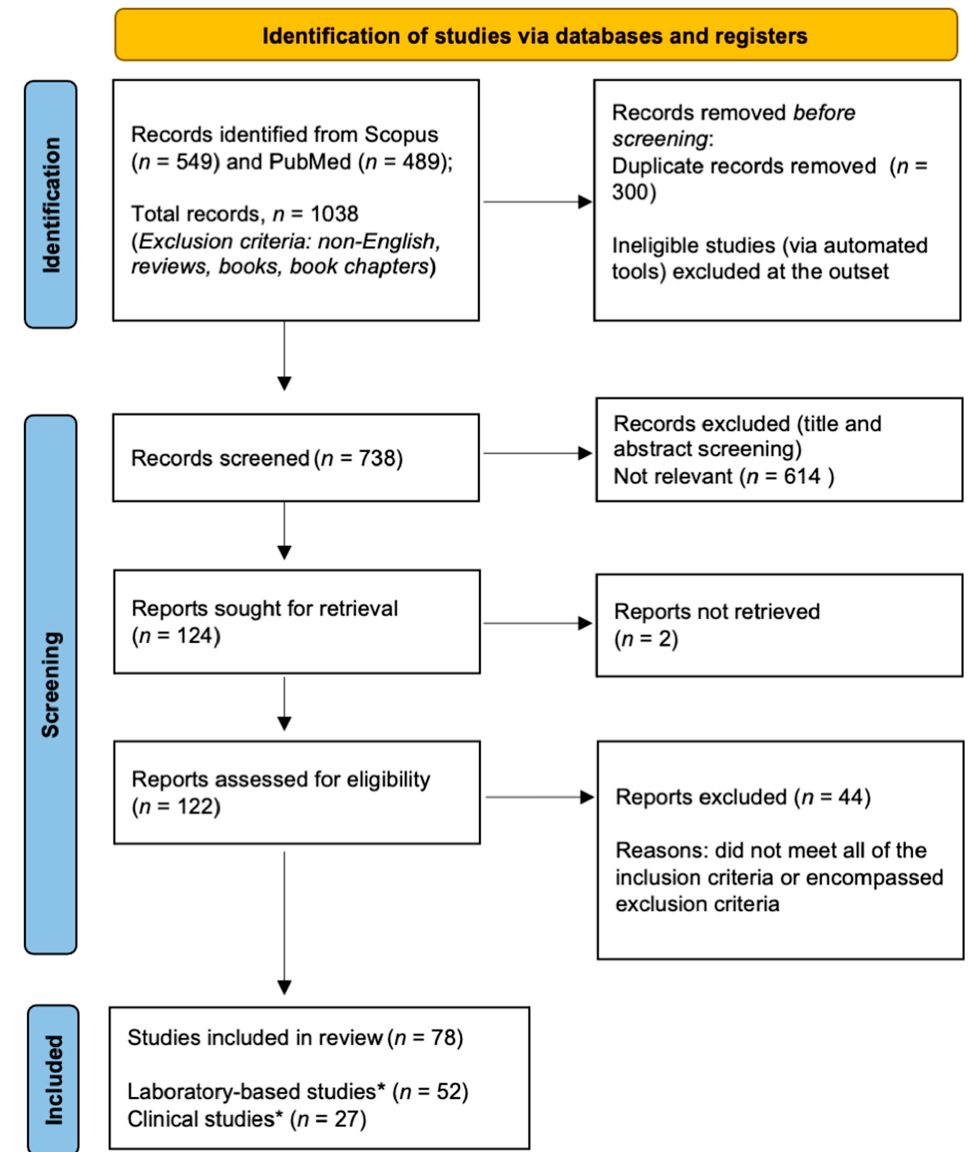
Figure 1. Flow chart of the selection process according to PRISMA-ScR guidelines. Asterisk (*) denotes the inclusion of a dual (laboratory-based and clinical) study.